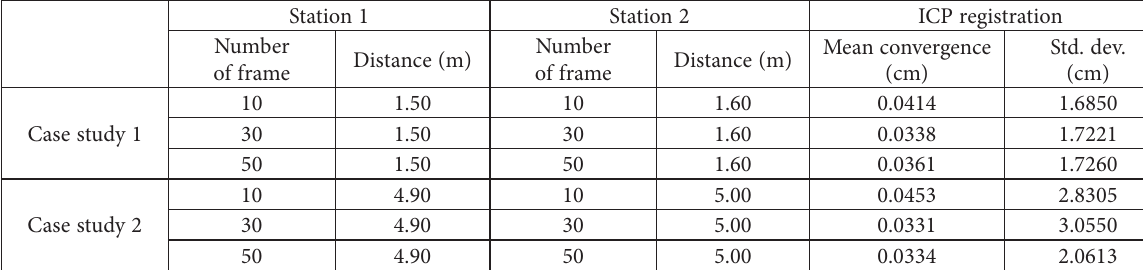
Table 1. The registration results of SR4000 point clouds by ICP